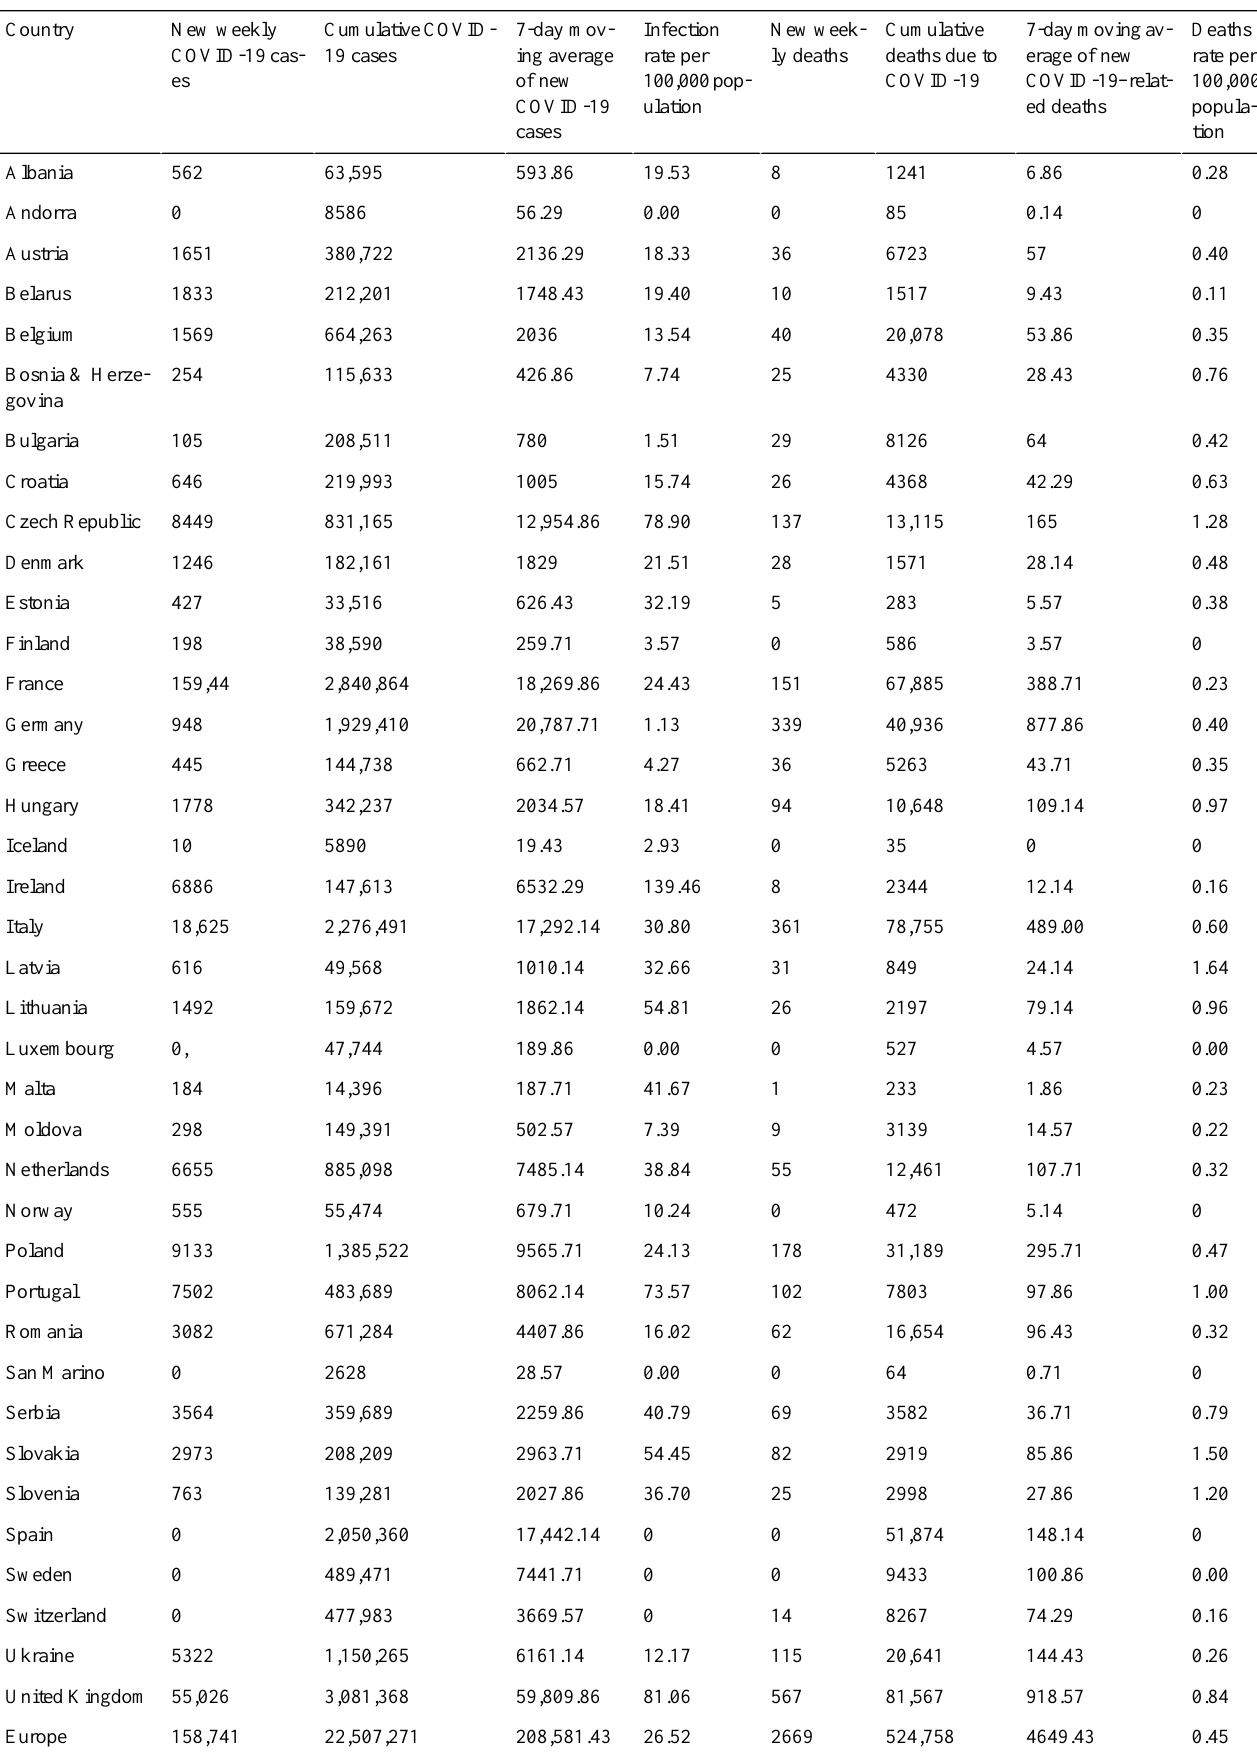
Table 2. Static surveillance metrics for European countries for the week of January 4-10,